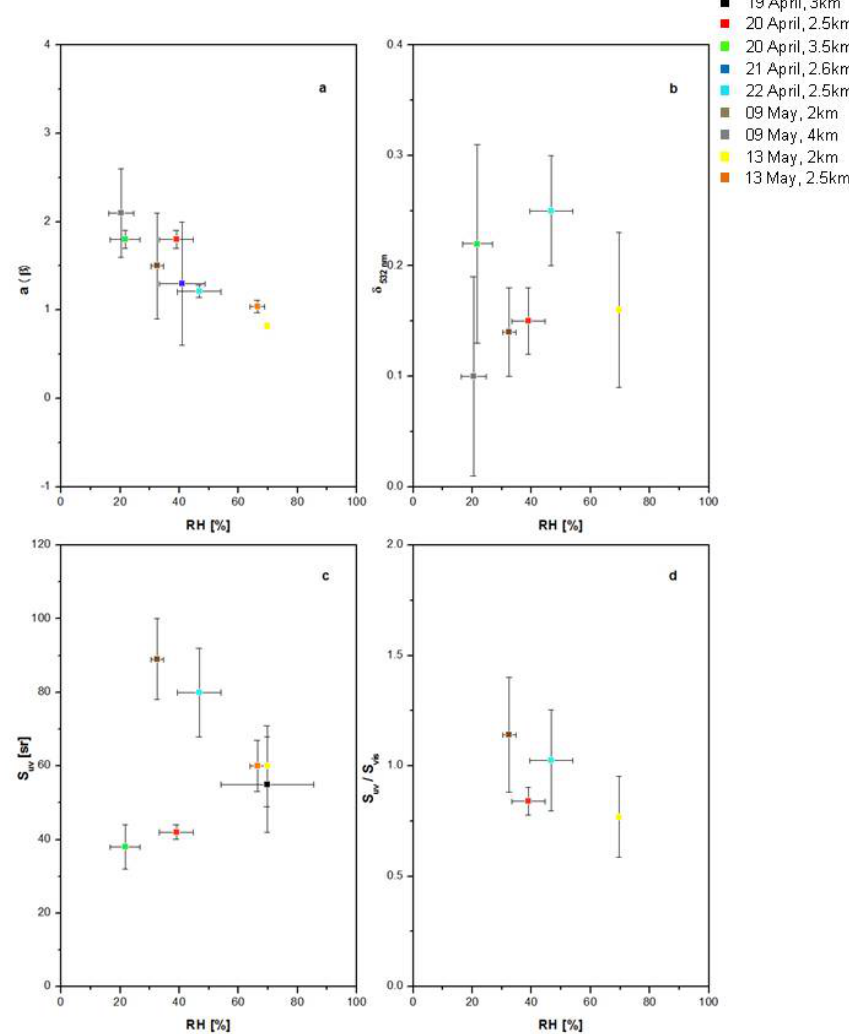
Fig. 6. Intensive properties as a function of the relative humidity, measured by the microwave profiler at CIAO. Mean values measured in the identified volcanic layers are reported. (a) Backscatter-related ˚Angstr¨om exponent at 532/1064nm ( ˚a ( β )); (b) particle linear depolarization ratio at 532 nm ( δ 532nm ); (c) the lidar ratio at 355nm ( S uv ) ; (d) ratio of lidar ratios in the UV and visible ( S uv / S vis ) . Standard deviations for layers at specific altitudes are indicated by the error